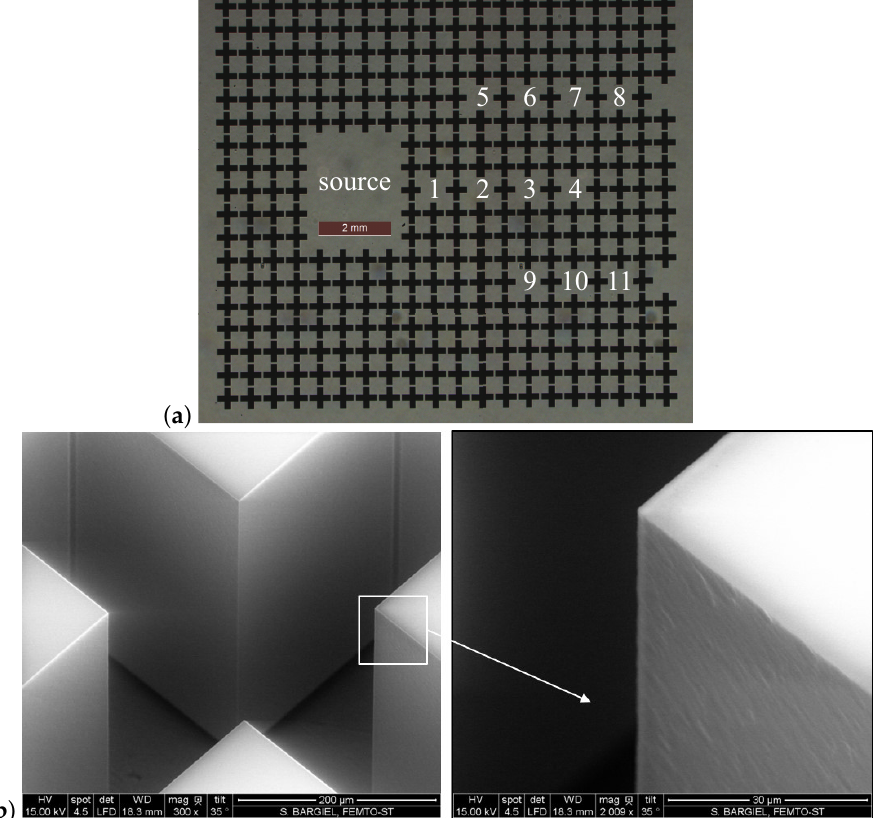
Figure 1. ( a ) Optical microscope image of the sample considered in this work. The 500 µ m-thick fused silica plate is processed by femtosecond laser-assisted wet etching (FLAE). Cross-holes are removed from the plate to define a phononic crystal slab structure with 18 rows and 20 columns. Defects, numbered from 1 to 11, define a set of three coupled-resonator waveguide cavities. The source region, placed inside the crystal structure, is in contact from the bottom with a piezoelectric vibrator. Out-of-plane displacements of the top surface are measured by a scanning laser vibrometer. The lattice spacing is a = 714 µ m. ( b ) Scanning electron microscope view of a cross-hole and zoomed view at a corner showing the side-wall